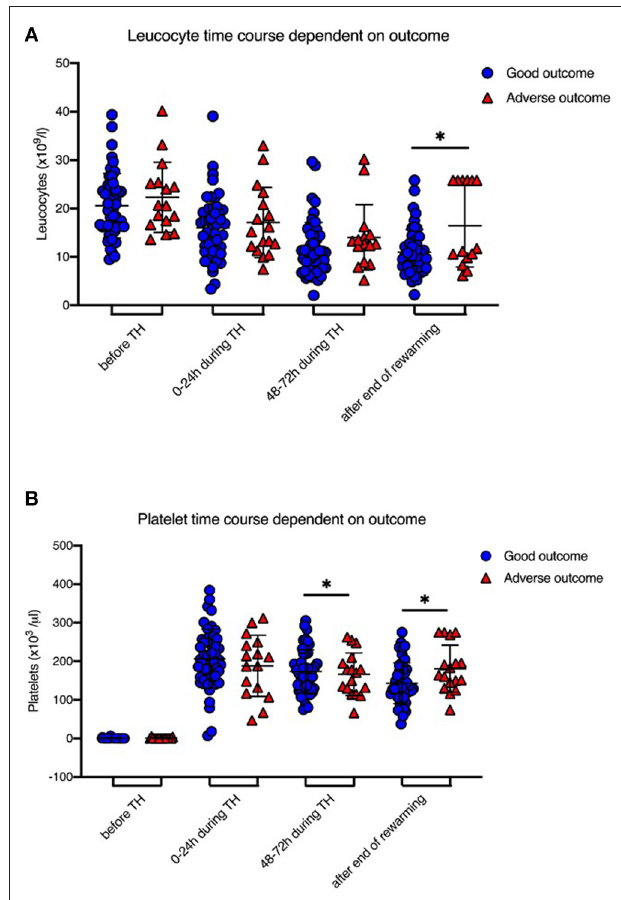
FIGURE 3 | Leucocyte and Platelet levels during therapeutic hypothermia. (A) Leucocyte levels were decreased after initiation of TH in both groups, however leucocytes were significantly higher in newborns with death or adverse MRI findings, defined as BG/W score > 2, after rewarming. (B) Platelet counts were significantly higher at the end of TH and after rewarming in newborns with death or adverse MRI findings. Data presented as mean ± standard deviation (SD), * p <